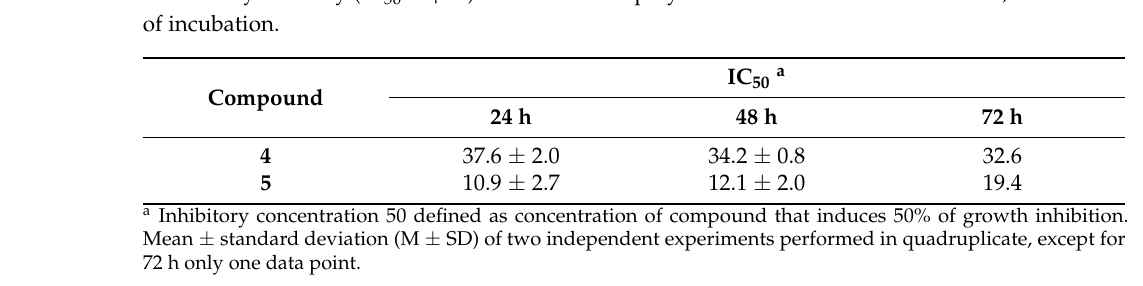
Table 3. Range of selectivity index (SI) values of compounds against fungal strains. Fungal